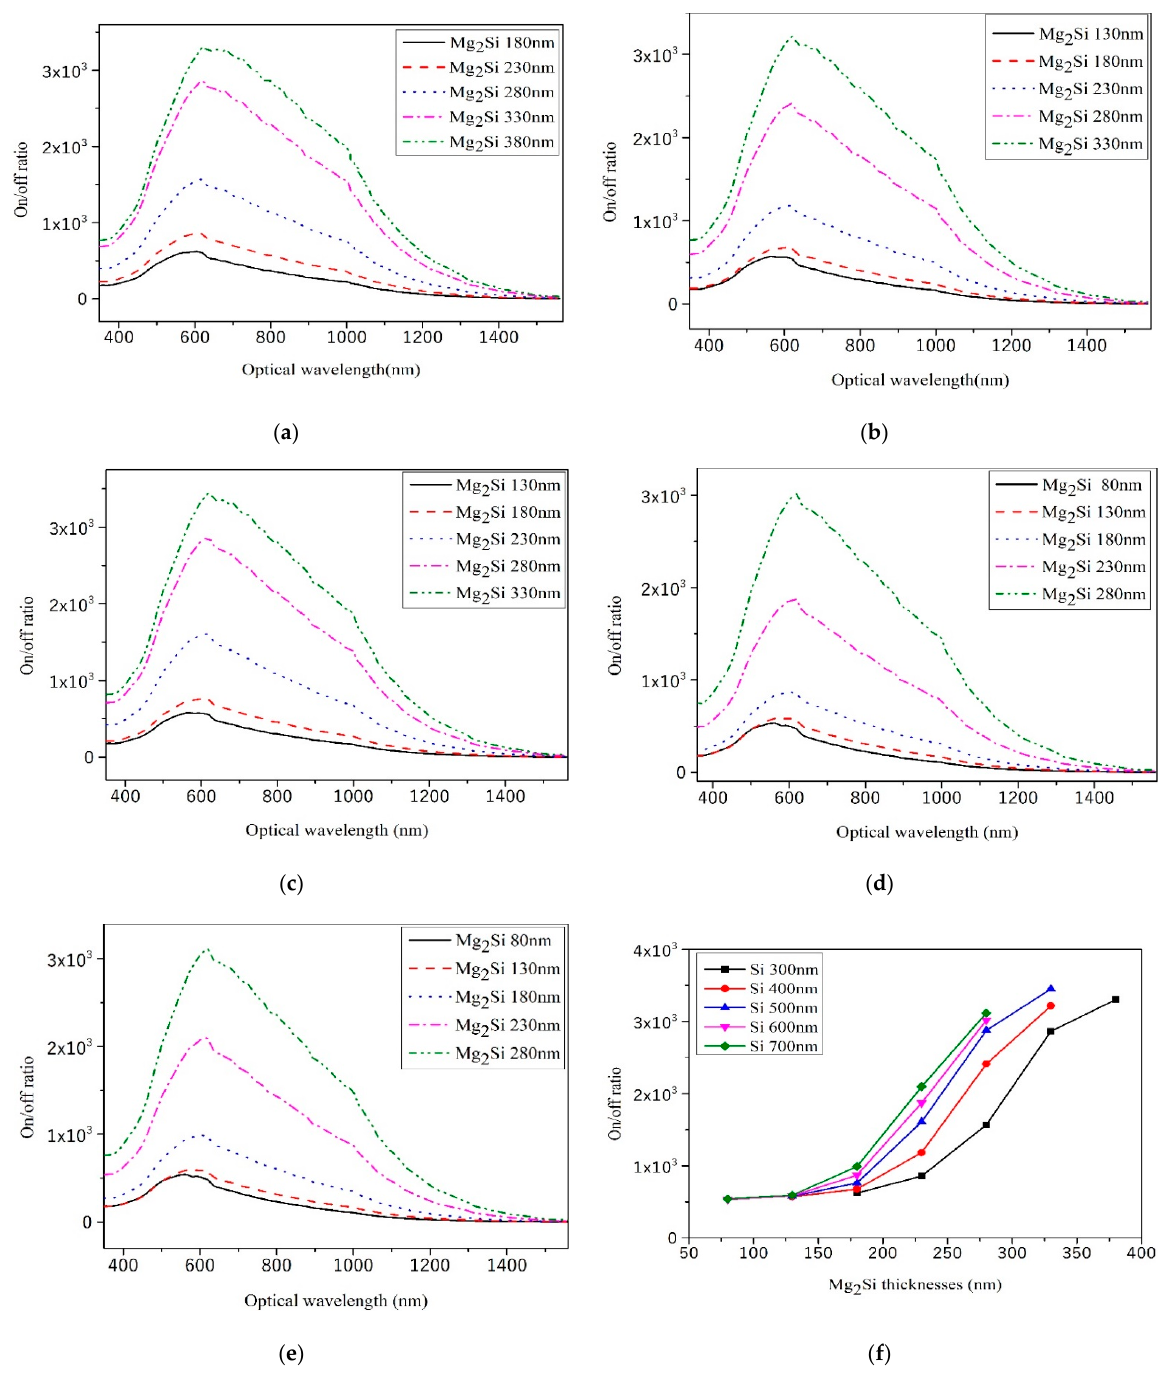
Figure 11. The on/off ratio curves of heterojunction PD with different Mg 2 Si thicknesses under the condition of 300 nm, 400 nm, 500 nm, 600 nm, and 700 nm thicknesses of Si. ( a ) Si-300 nm; ( b ) Si-400 nm; ( c ) Si-500 nm; ( d ) Si-600 nm; ( e ) Si-700 nm; ( f ) The effect of thicknesses on the on/off ratio.